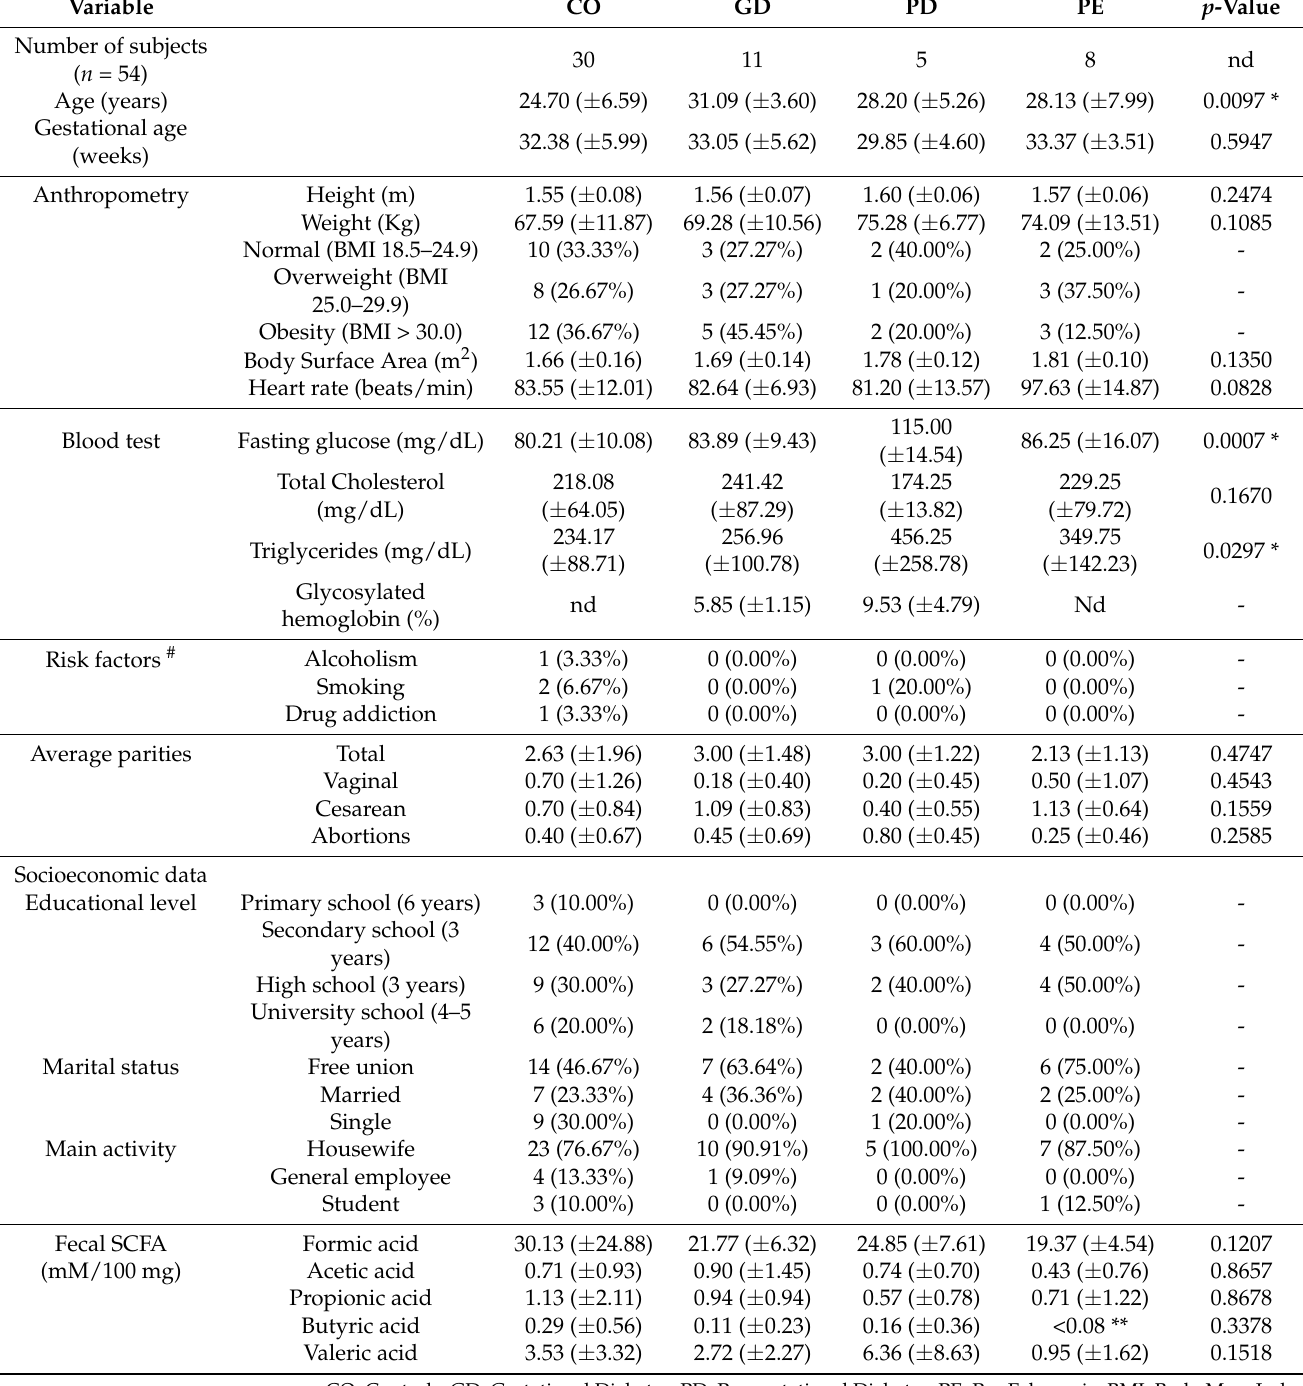
Table 1. General data for participants of the study by